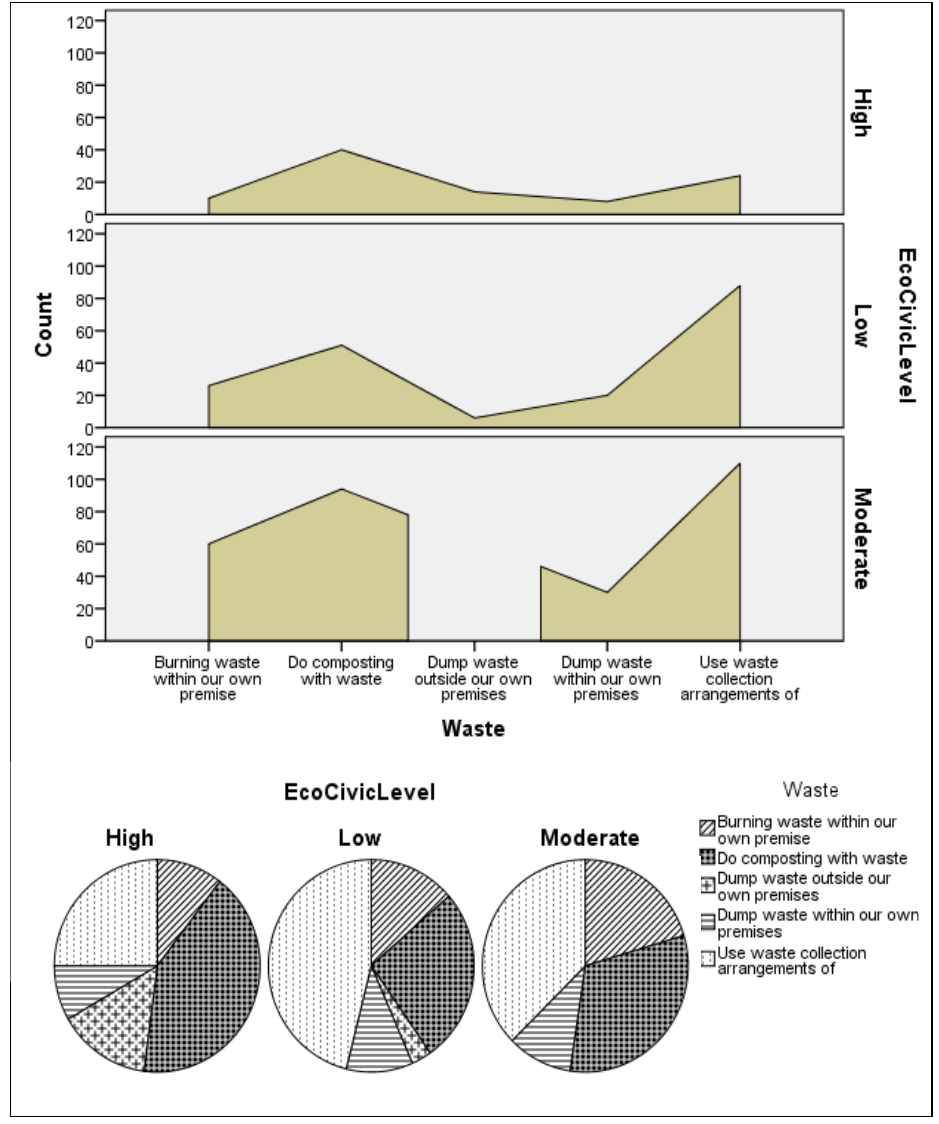
Figure 04: Eco-civic engagement levels and Waste disposal